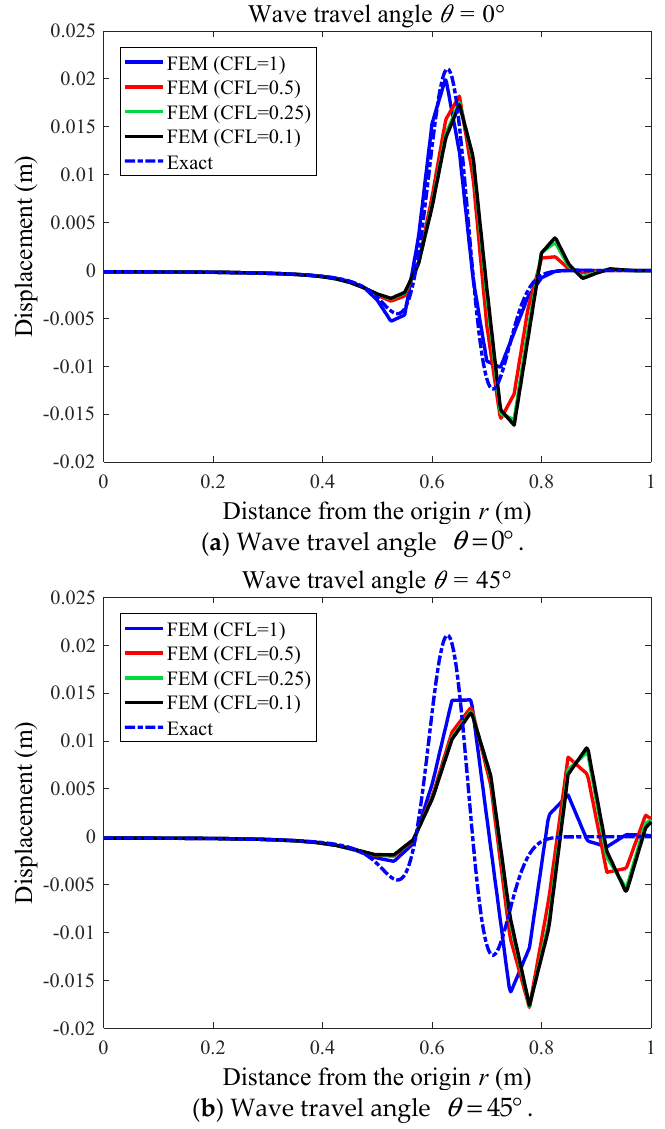
Figure 9. The displacement responses of the square membrane from the FEM by varying the employed nondimensional temporal discretization interval.